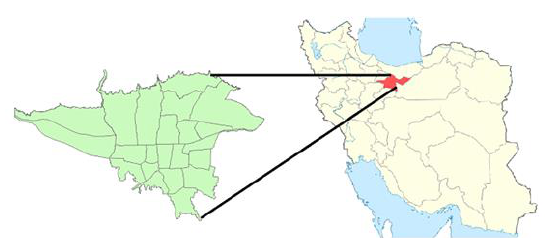
Figure 1. Study area Tehran,